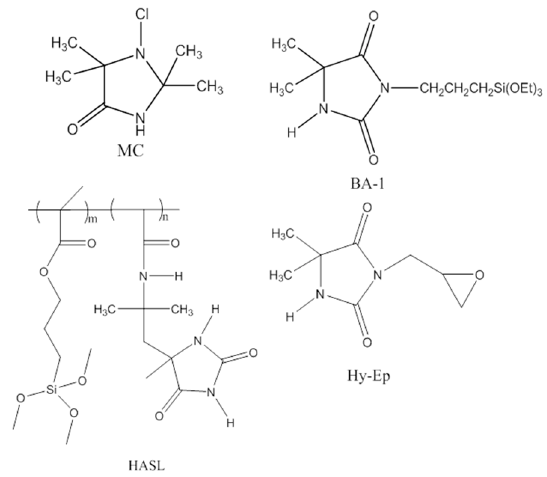
Figure 1. Synthesized N-halamine compound or precursors.